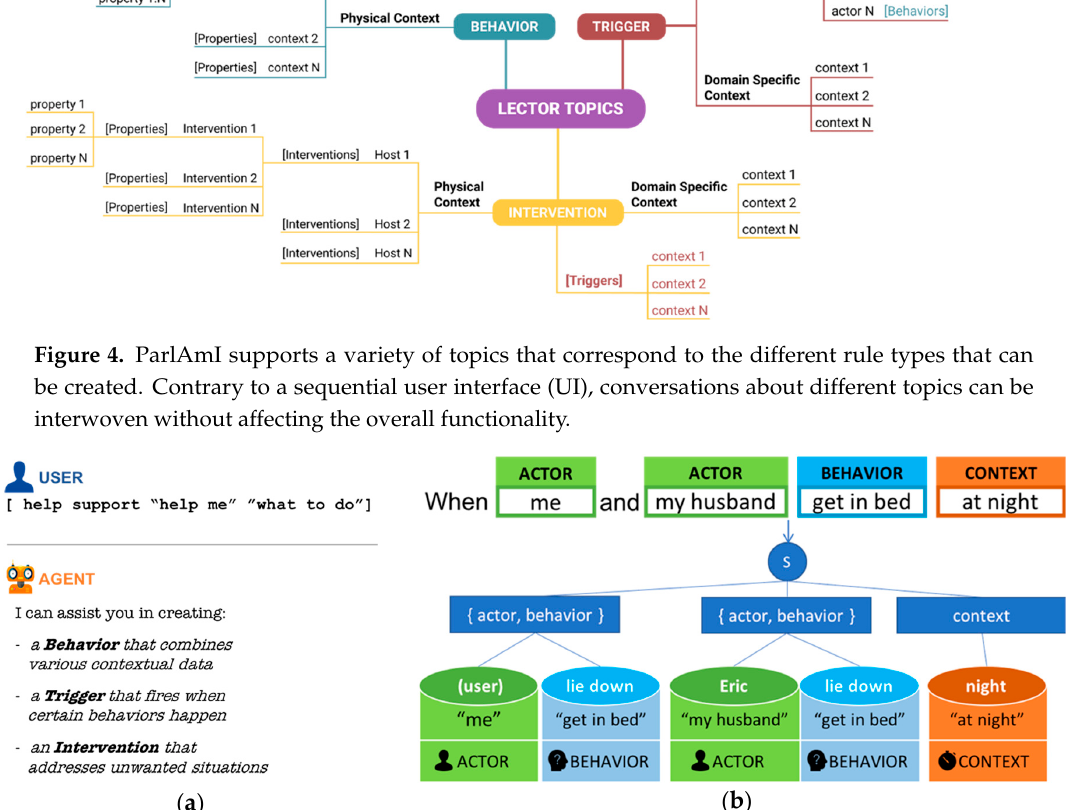
Figure 5. ( a ) Pattern that identifies user intention to ask for help and get informed about the bot’s facilities; ( b ) a sample of the ParlAmI’s enhanced syntax tree.